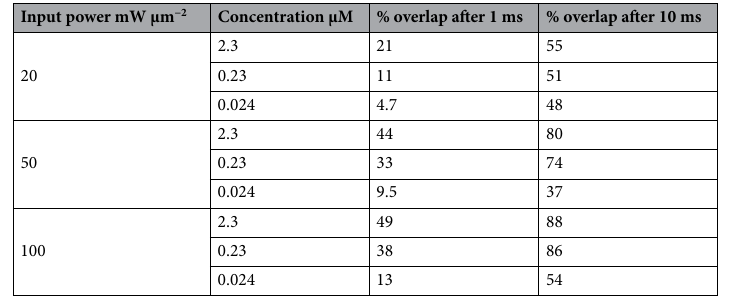
Table 1. The percentage of overlapping particles after optical